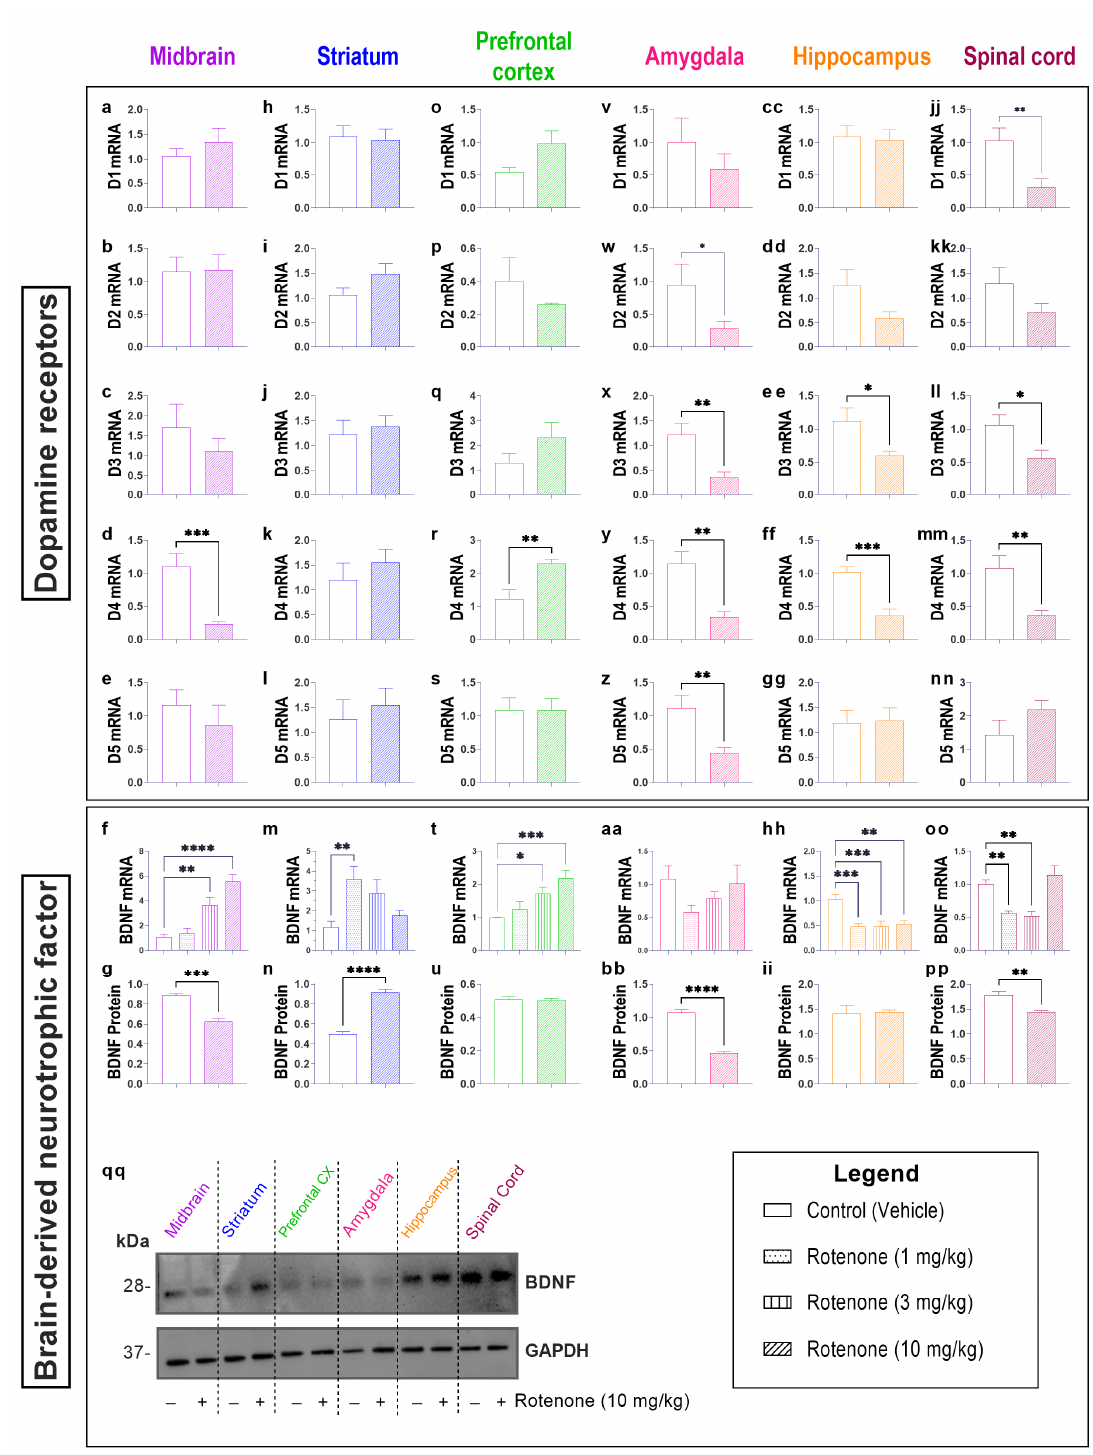
Figure 3. Rotenone disturbs the expression of dopamine receptors and brain-derived neurotrophic factor in specific CNS-regions. On day 22, mice from vehicle- and rotenone-treated groups (10 mg/kg) were sacrificed and midbrains, striata, prefrontal cortices, amygdala, hippocampi and spinal cords were collected for real-time qPCR analyses. mRNA expression of the five dopamine receptors